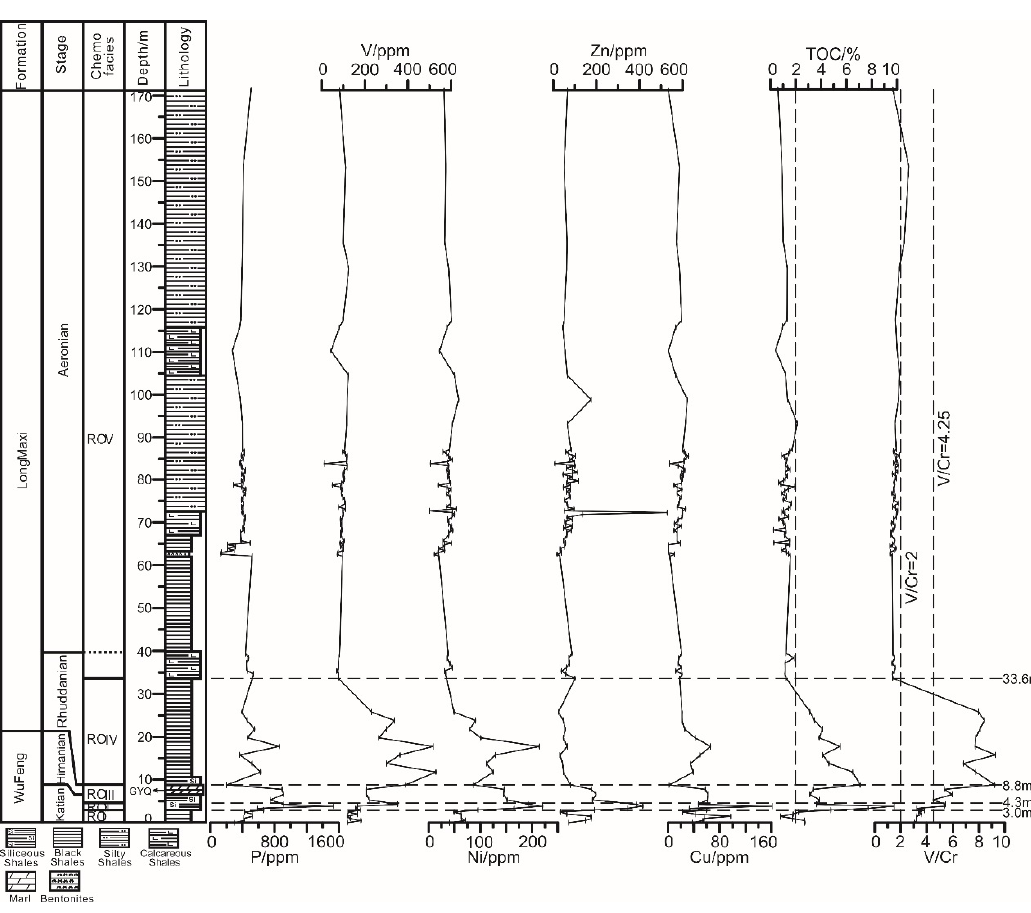
Figure 5. The chemozonation based on redox-organic chemofacies of the Changning section.